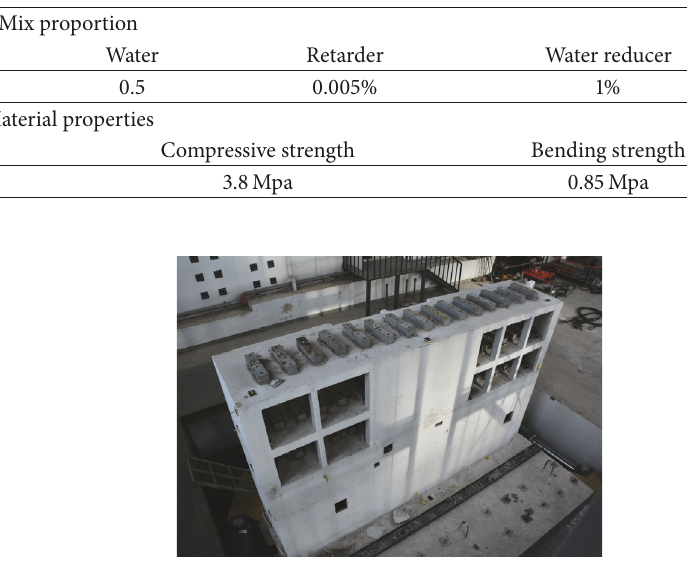
Table 2: Mix proportion and material properties.